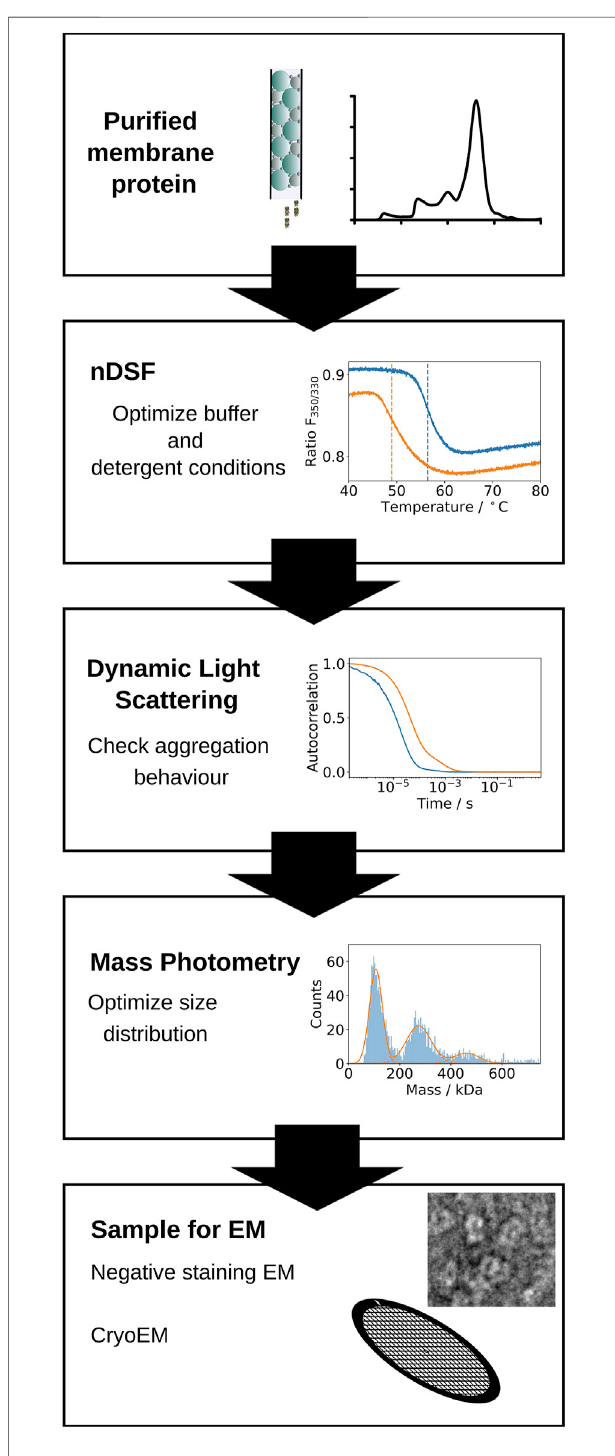
FIGURE 1 | Schematic representation of the screening pipeline proposed. First, optimal buffer and detergent conditions for the stability of a puri fi ed membraneproteinsampleareidenti fi edbynDSF.Selectedconditionsareusedfor further screening by Dynamic Light Scattering (DLS) to determine the aggregation status of the protein under the speci fi c buffer and detergent conditions. Mass photometry measurements are used to con fi rm the expected molecular weight of the protein and the distribution of masses present in the sample.Finally,thesampleisimagedsuccessivelybynegativestainandcryo-EM.